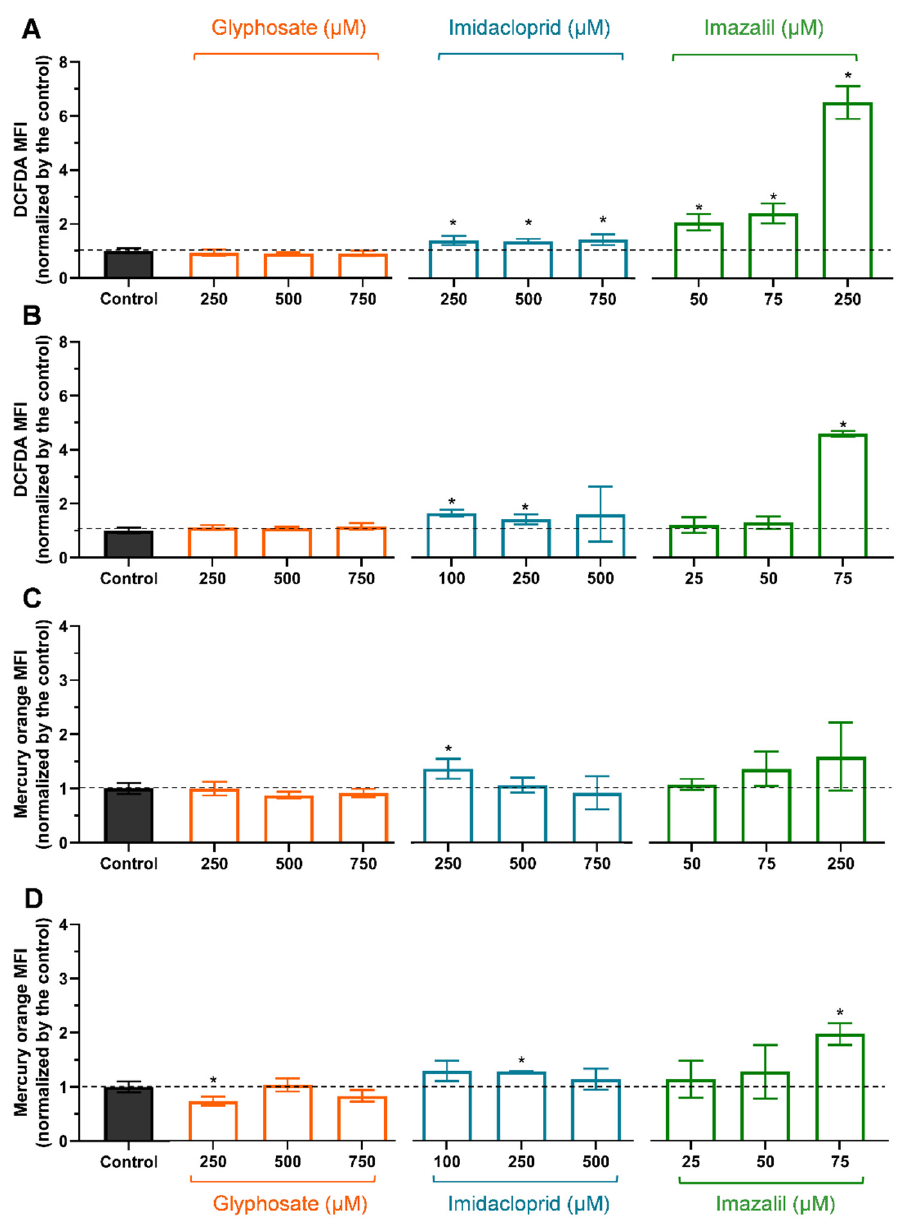
Figure 3. Changes in intracellular reactive oxygen species (( A ): Caco-2; ( B ): HepG2) and glutathione (( C ): Caco-2; ( D ): HepG2) contents, induced by cells exposure to GLY, IMD, and IMZ, for 24 h, at the indicated concentrations. Results are presented as mean ± SD. Values were normalized to control cells (non-exposed cells). Significant statistical differences between the control and samples are denoted as “*” when p <